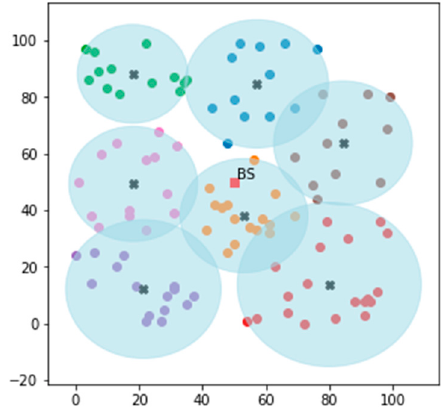
Figure 8. Depiction of network clusters with centroids.